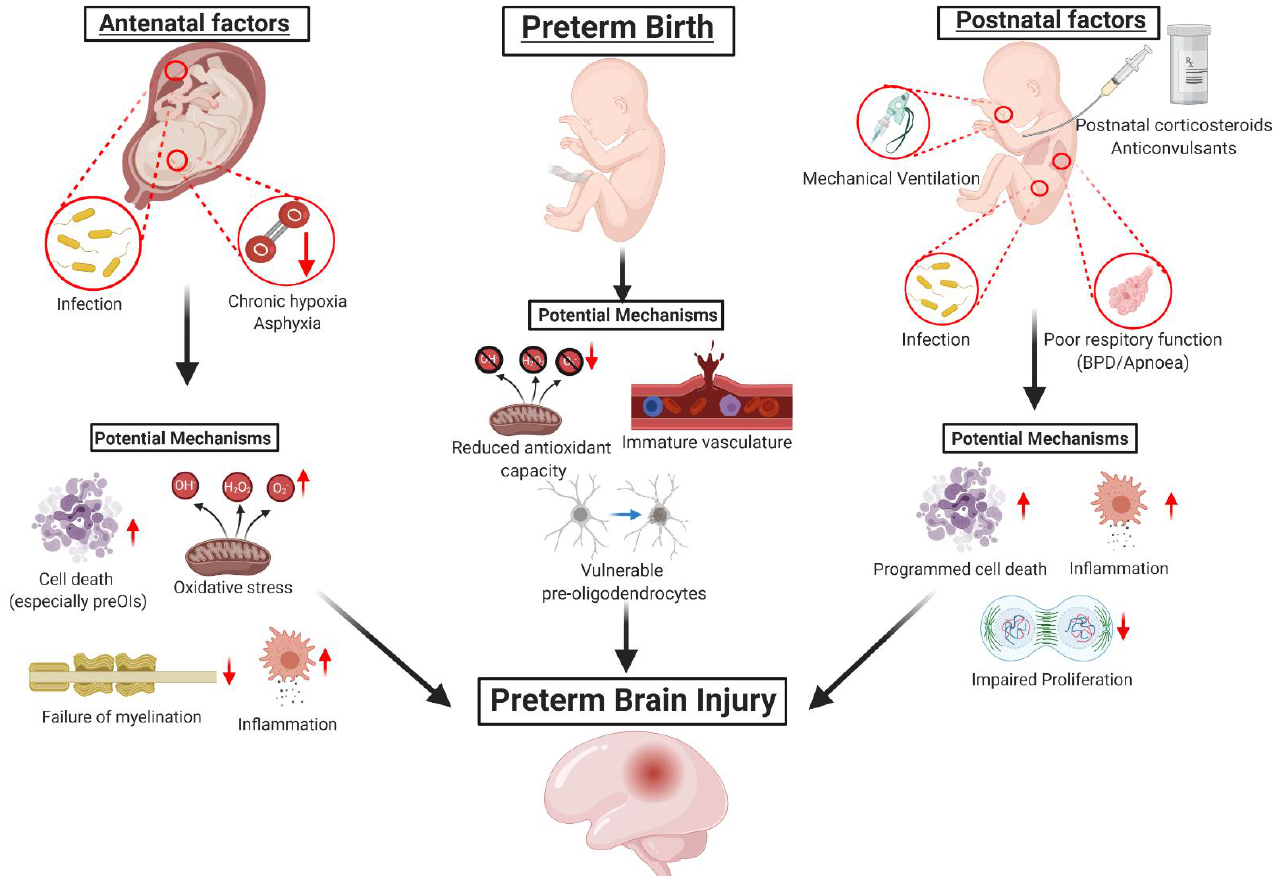
Figure 1. Potential factors contributing to preterm brain injury.